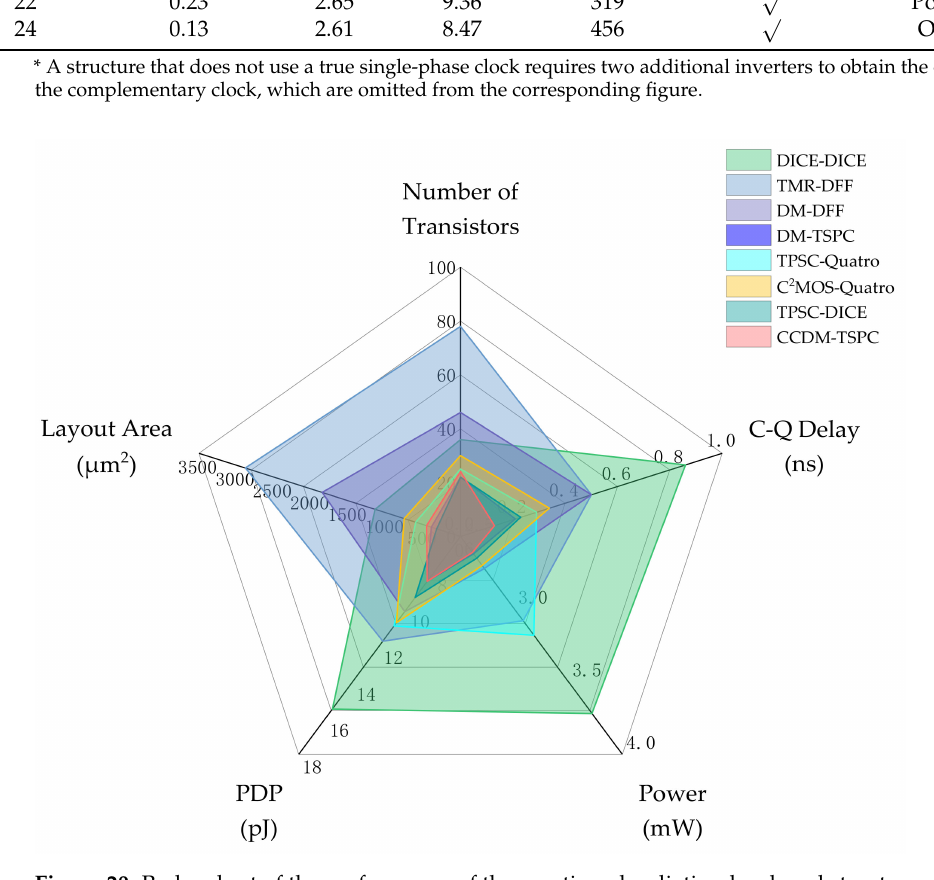
Figure 20. Radar chart of the performance of the mentioned radiation-hardened